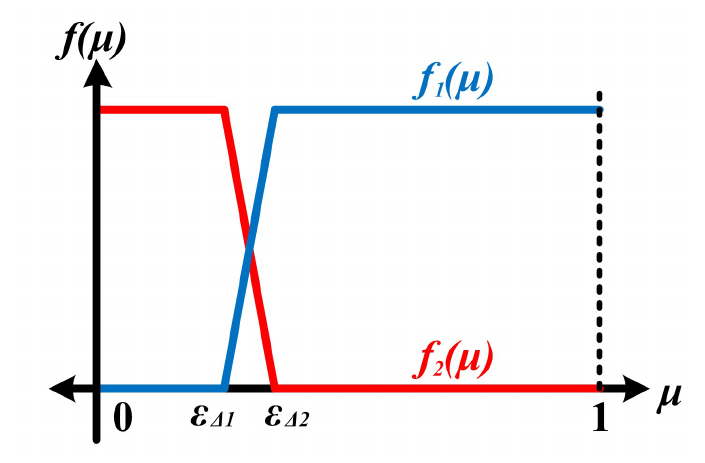
Figure 8. Membership function for feedforward q-axis current